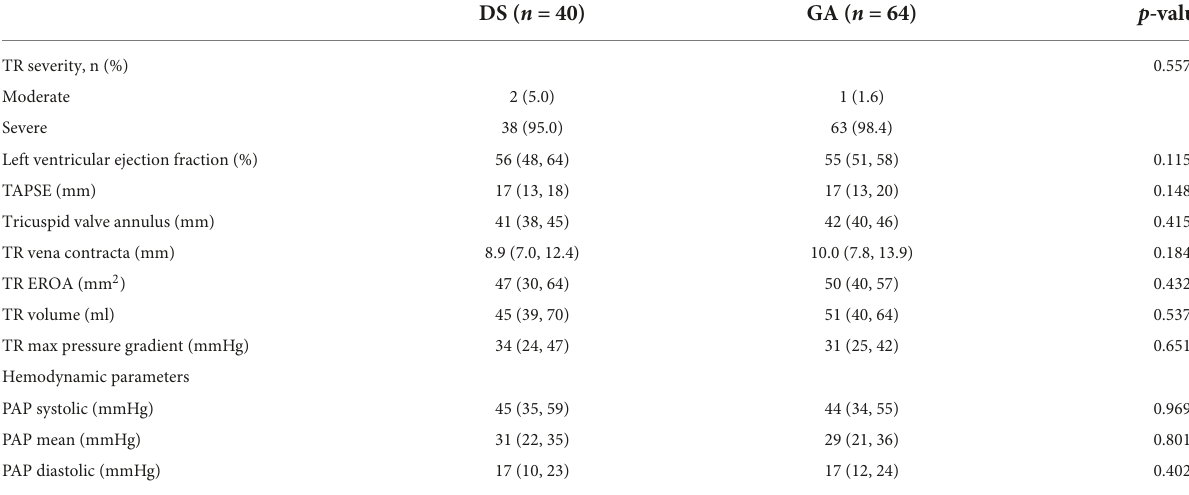
TABLE 2 Baseline echocardiographic and hemodynamic parameters of TR patients grouped according to the device system used for